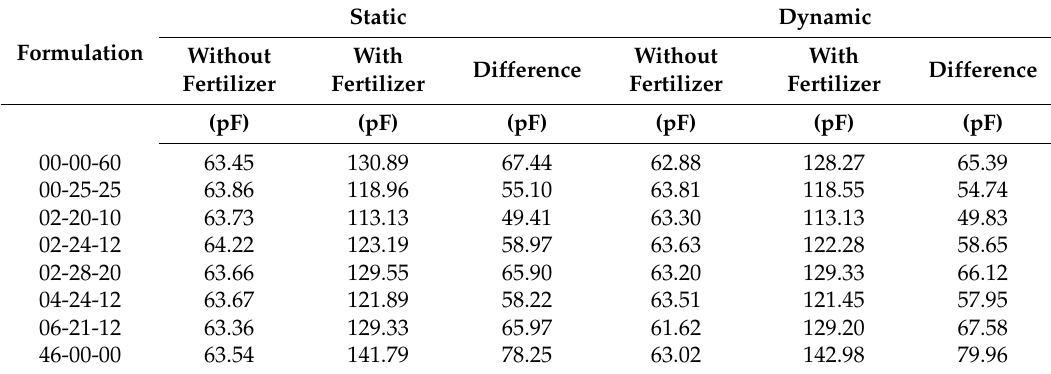
Table 1. Capacitance difference in the absence and in the presence of the dielectric.